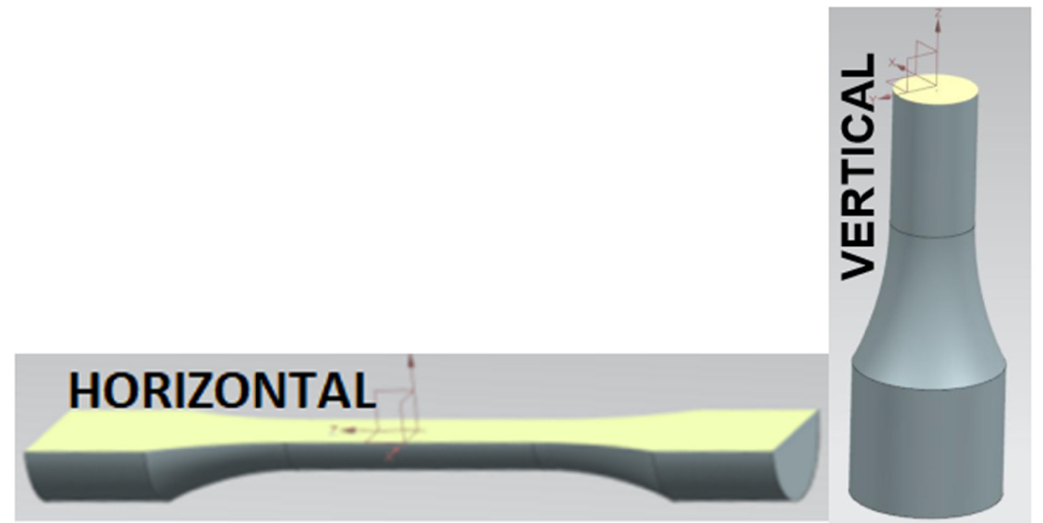
Figure 4. Directions of material layering in the production of the test specimens. The results of the cyclic tests in the controlled force mode in the form of Basquin relations [27] are shown in Figure 5.